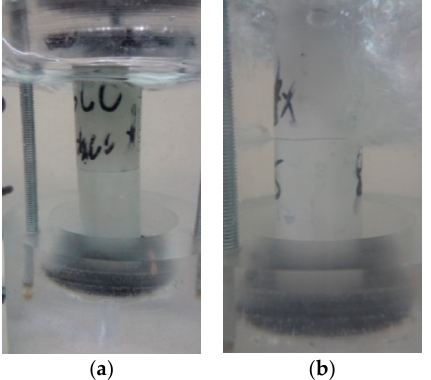
Figure 6. View of sample of adhesive joint (PP-25): ( a ) leak-proof sample made by Loctite 3430 A&B Hysol adhesive; ( b ) leaky sample made by Loctite 406.